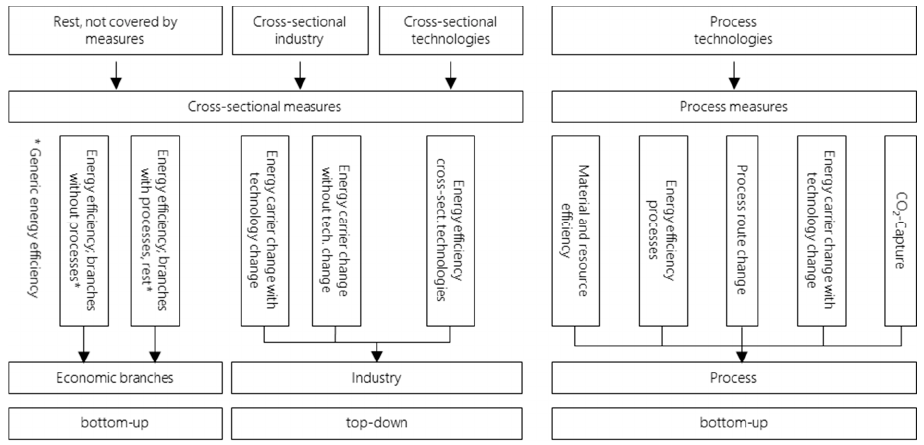
Figure 4. Assignment of modelled technologies to the measure categories and effect level.